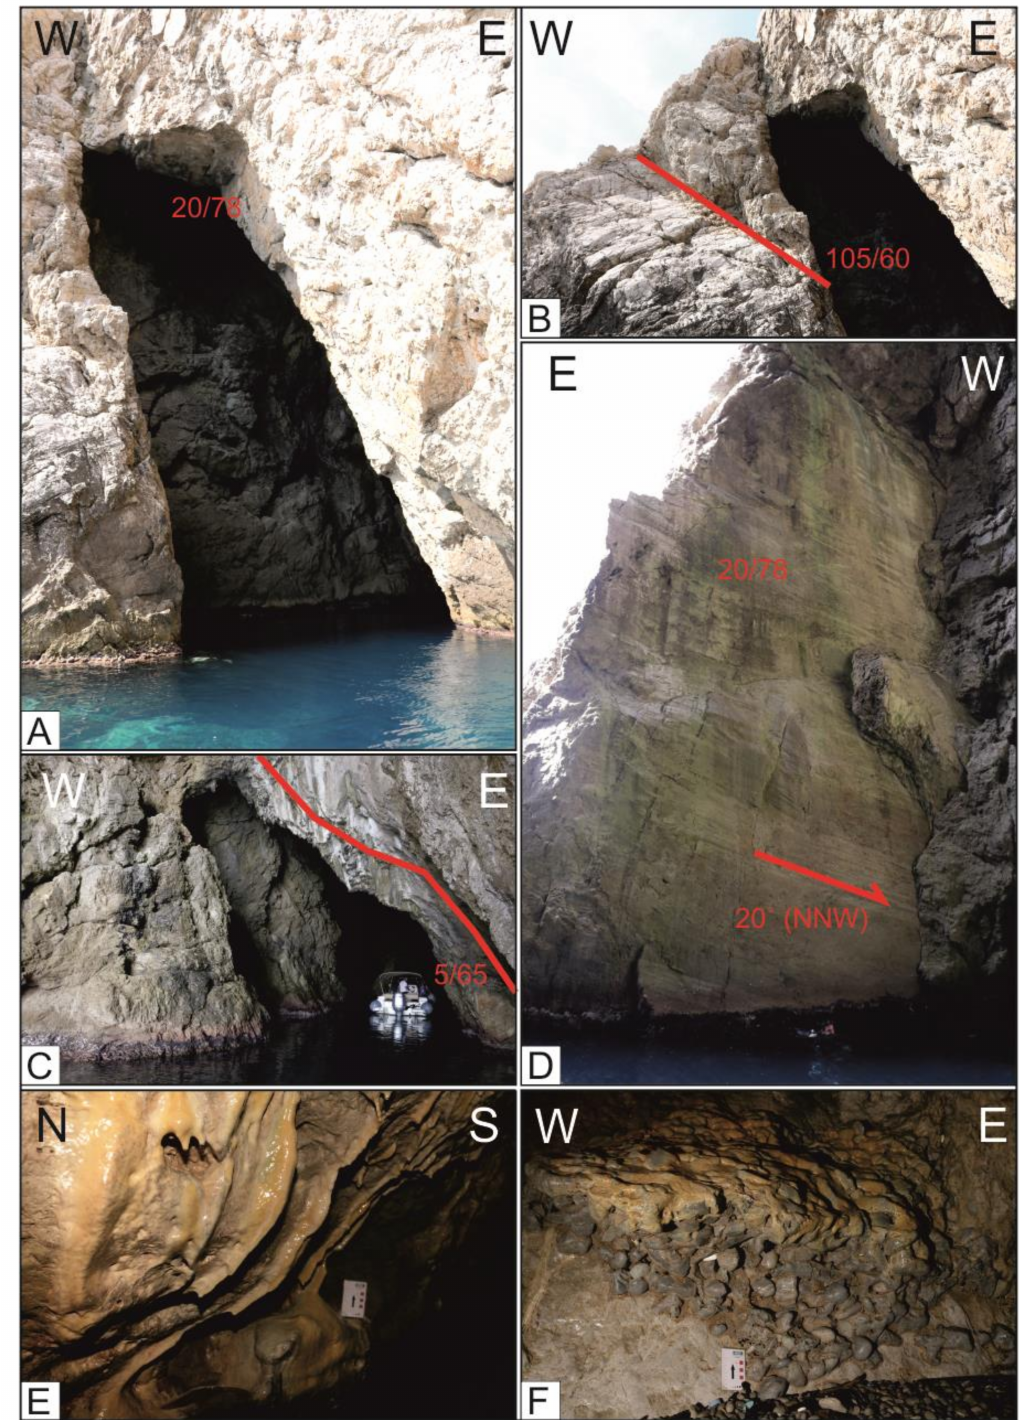
Figure 7. On the photographs of the Monk Seal Cave, structural measurements are marked. The red lines mark fault planes (dip direction/dip angle are marked in red numbers). ( A ) Entrance to the Monk Seal Cave. ( B ) Fault plane observed on the entrance to the cave. ( C ) Fault plane in the middle section of the cave, located at the ceiling. ( D ) WNW–ESE striking strike-slip fault plane at the entrance to the Monk Seal Cave (The Tectonic Gate), with marked slip direction (dextral movement). ( E ) Speleothems at the furthest section in the cave. ( F ) Paleo beach conglomerates at the northern tip of the Monk Seal Cave, located 0.5 m above a small pebbly